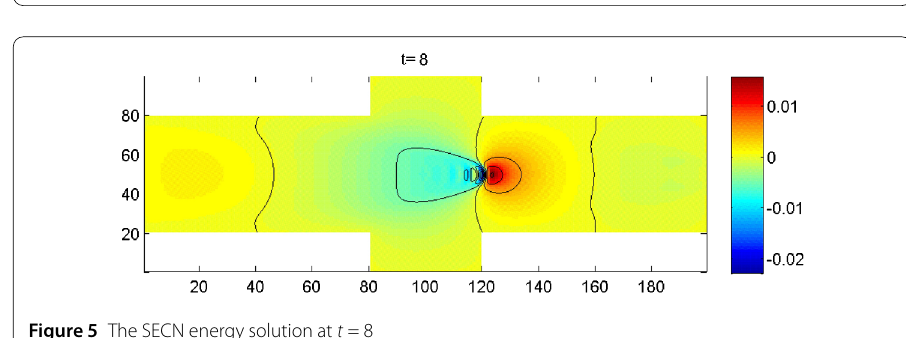
Figure 4 The SECN velocity solution at t = 8